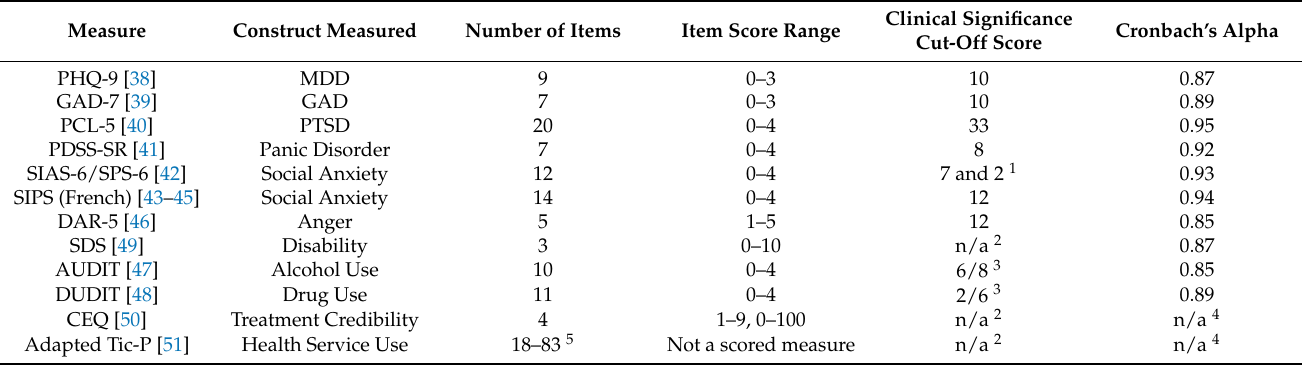
Table 1. Self-report